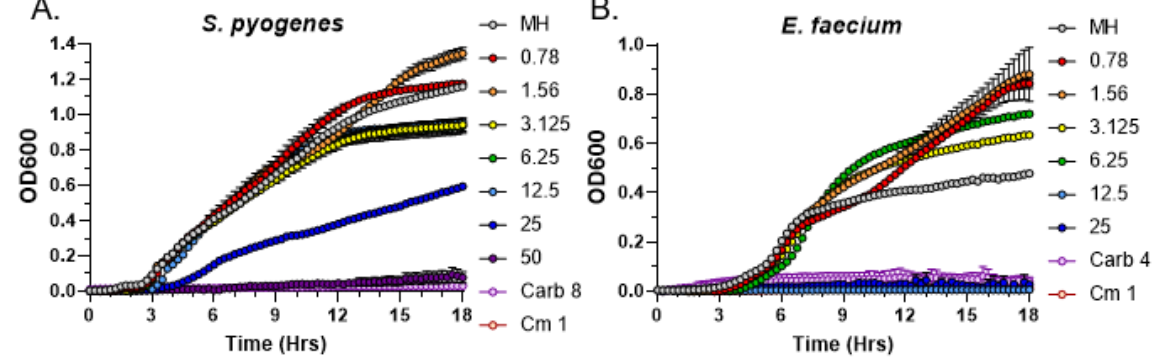
Figure 4. Analysis of the Minimal Inhibitory Concentration of C. purpureus R40 exudates against other Gram-positive bacteria. Exudates from four-week-old C. purpureus R40 strain were tested in MIC assays against S. pyogenes ATCC12344 ( A ) and E. faecium ATCC35667 ( B ). Growth curve of S. pyogenes and E. faecium cells was monitored in the presence of 0.781, 1.56, 3.125, 6.25, 12.5, 25, and 50 mg/mL of exudate solution. MH — negative control, no exudate added. Carbenicillin (Carb, 8 µg/mL or 4 µg/mL) and chloramphenicol (Cm, 1 µg/mL) treatments were used as positive controls for growth inhibition of S. pyogenes and E. faecium .